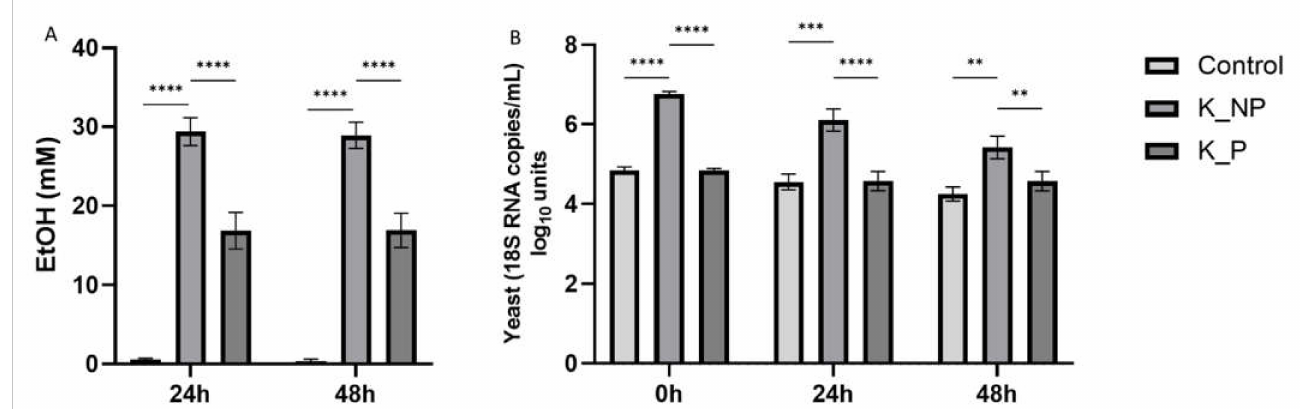
Figure 5. Effect of kefir products on ethanol and yeast levels. ( A ) Bars represent mean ± SEM ( n = 3) of EtOH (mM) levels different reactors exposed to non-pasteurized and pasteurized kefir products for 24 and 48 h. ( B ) Bars represent the mean ± SEM of yeast 18S RNA copies/mL quantified by qPCR at different time points. Significant differences between control condition and treatments or between non-pasteurized and pasteurized products are marked by (**), (***) and (****) p < 0.05, p < 0.01, p < 0.001 and p < 0.0001,